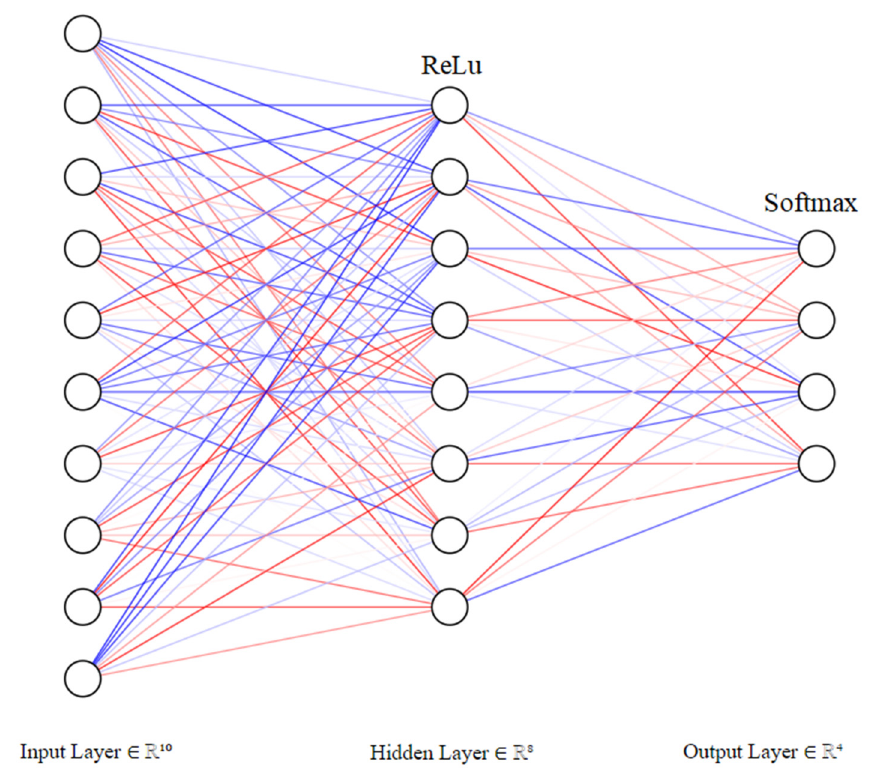
Figure 5. Neural Network Architecture.